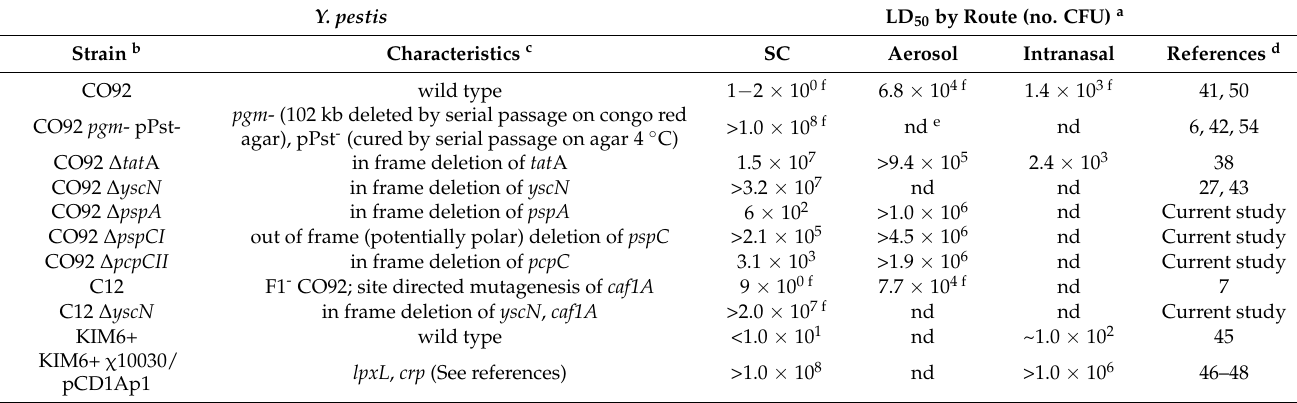
Table 2. Virulence attenuation in mice of candidate Y. pestis live plague strains. Y.